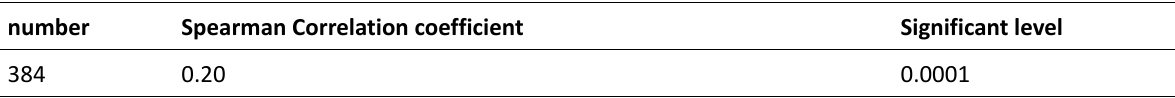
Table 5. The correlation between effective factors on spectators during watching and spectators’ physical activity using Spearman correlation